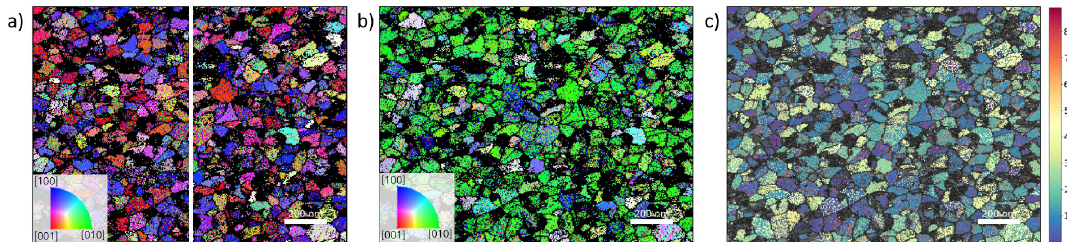
Figure 3. Crystallographic orientation of the grains in the (100)- and (010)-plane of the HSO sample, corresponding to the crystallographic in-plane axes, are visualized in ( a ). Crystallographic axes perpendicular to (001)-plane of the sample, thus resembling out-of-plane orientation, are shown in ( b ). The angle between the sample plane and the polarization axis of orthorhombic HfO 2 is visualized in ( c ).